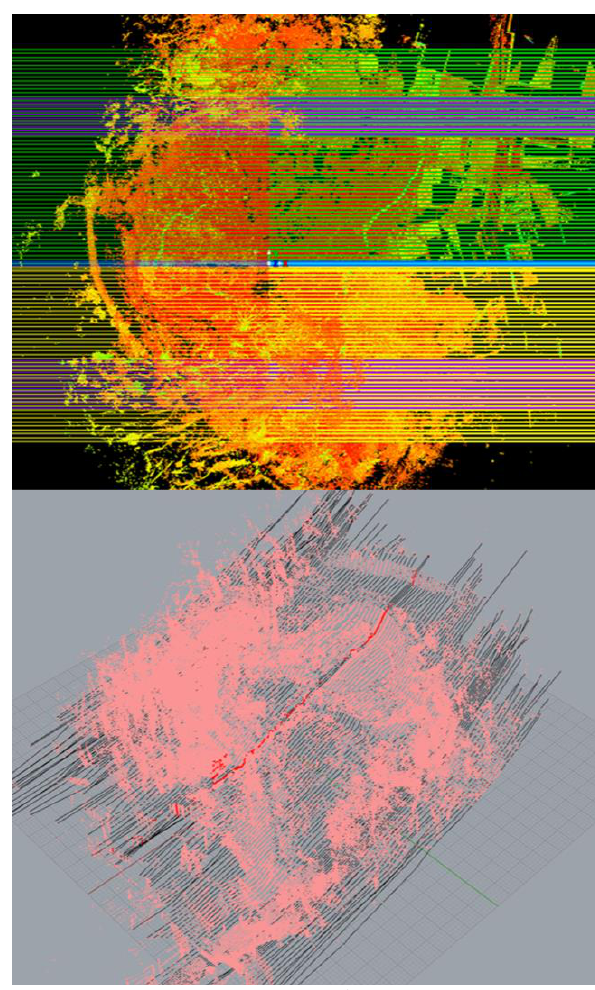
Figure 8 . Graphical representation of the process to export point cloud slices.